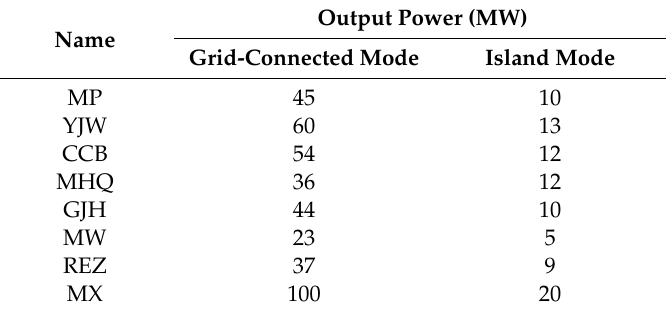
Table 6. The output powers of sources.